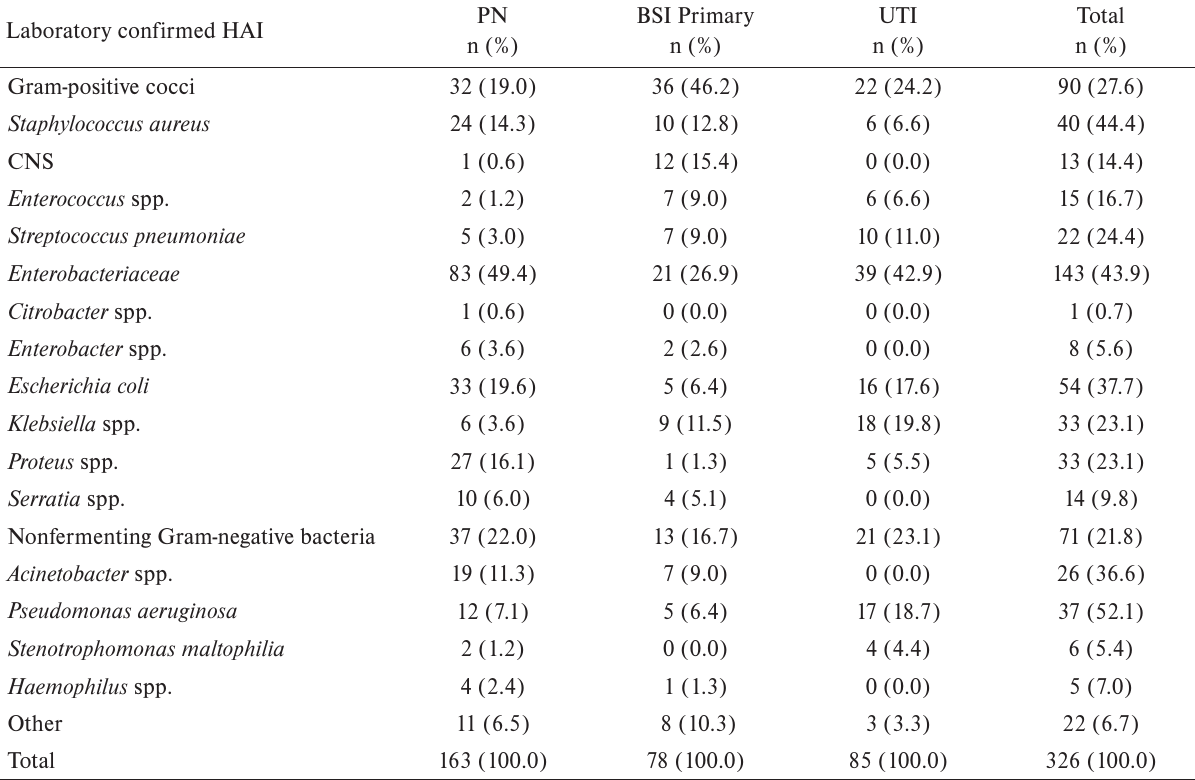
Table 3. Bacterial aetiology of Healthcare-Associated Infections in study intensive care